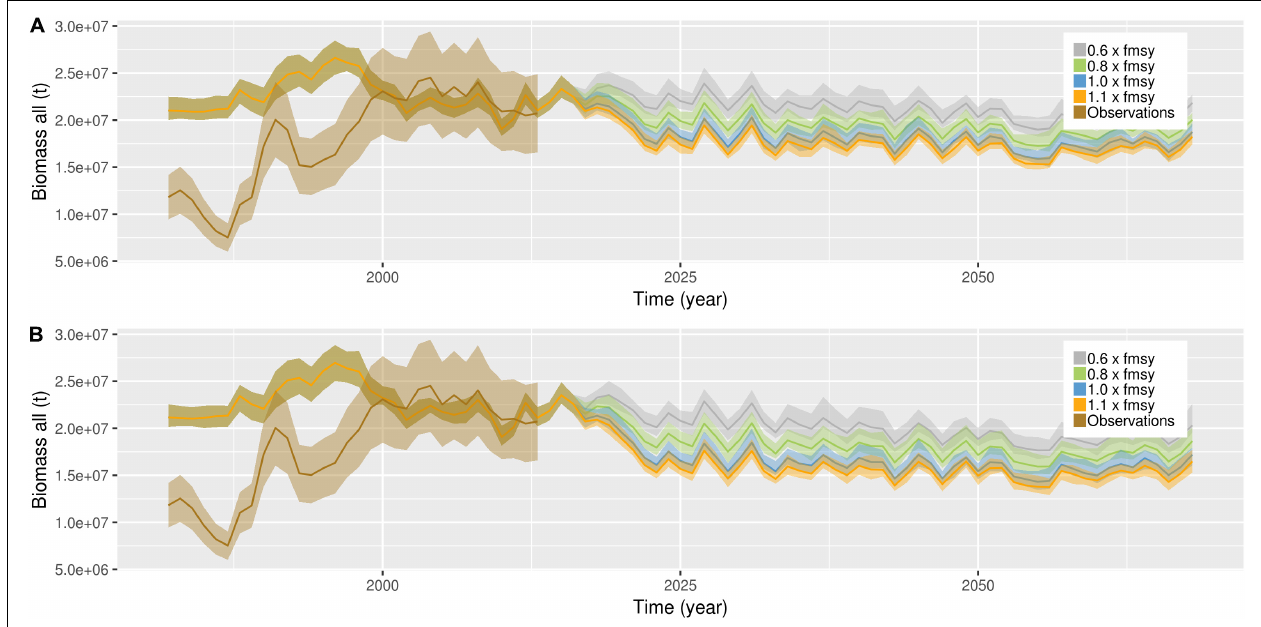
FIGURE 3 | Temporal development of pelagic biomass (biomass of cohorts included in the assessment) in the four scenarios only including commercial fish (A) and in the four scenarios including additional harvest on mesopelagic fish, other demersals, large demersals, zooplankton and small pelagic fish (B) . Brown (transparent) is observations of total biomass from assessment reports, including 20% uncertainty. Gray line represents global sustainability, green represents world market, blue represents local stewardship and orange represents national enterprise scenario. The shading represents one standard deviation from the mean of the 14 different simulations representing each